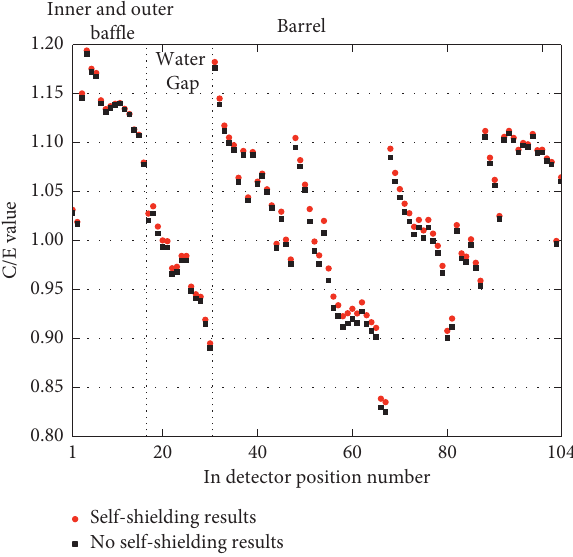
Figure 12: Comparison of self-shielding correction of the 115 In(n,n’) 115m In detector.